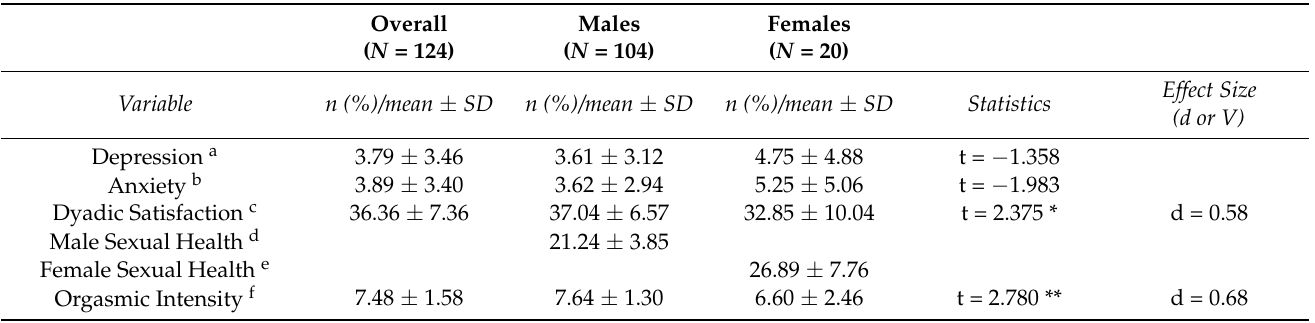
Table 2. Clinical outcomes and univariate comparisons between male and female subjects of the study sample.